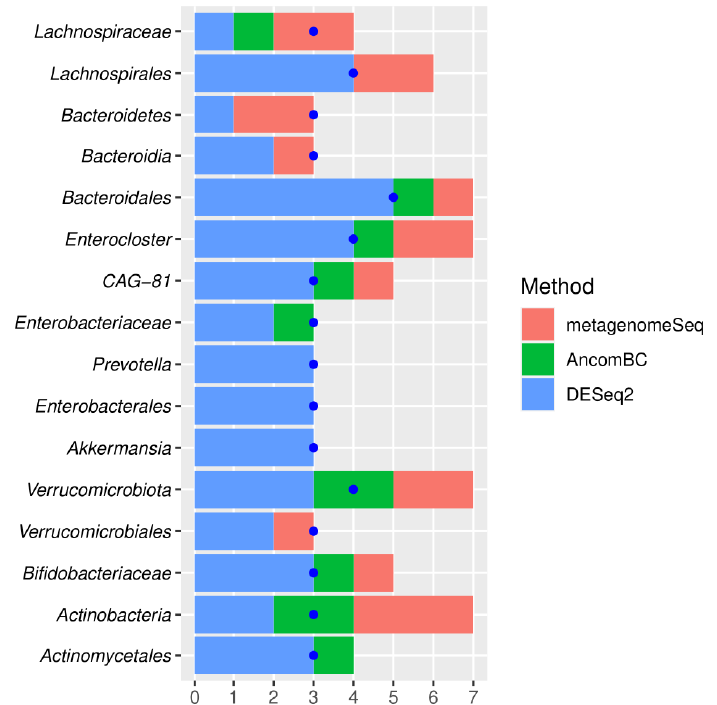
Figure 7. The results of a meta-analysis. Statistical significance testing for single datasets using metagenomeSeq, AncomBC, and DESeq2. The number of studies in which a given taxon was detected as significant by at least one method is denoted by a blue dot. Stacked bar charts show how many studies given differential abundance testing methods reported substantial results.